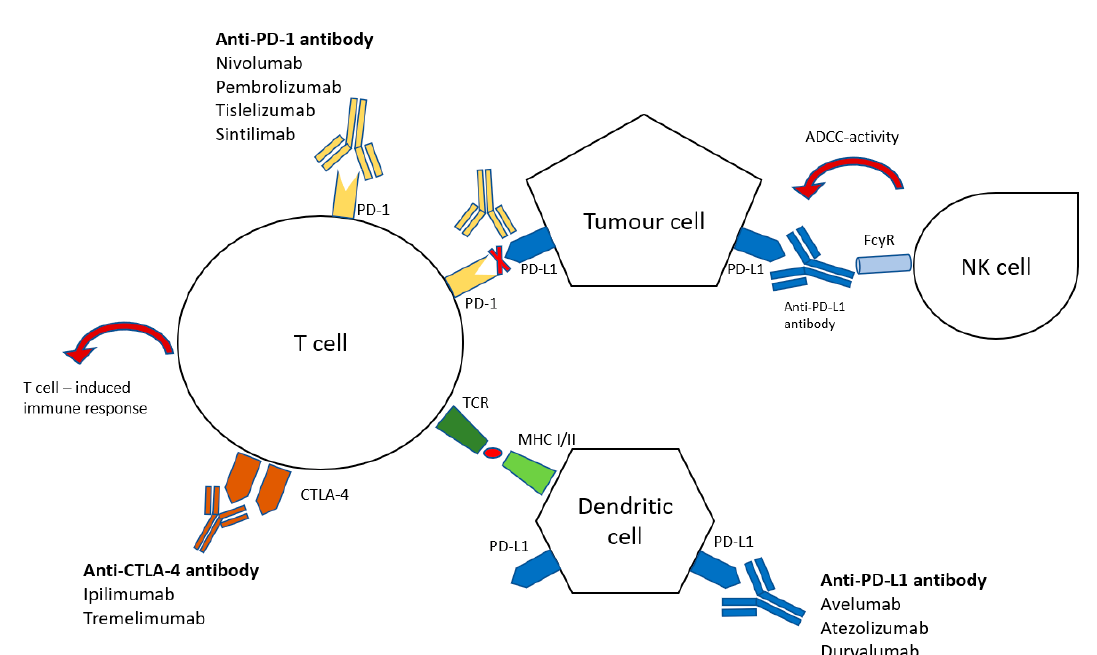
Figure 1. Functional interaction of immune system and tumour cells in checkpoint inhibition (adapted from Taieb et al., 2018 [13].) Blocking checkpoint proteins, PD-1 (programmed death receptor-1), PD-L1 (programmed death receptor ligand-1), CTLA-4 (anti-cytotoxic T-lymphocyte-associated antigen 4), amplify T-cell immune response against tumour cells by blocking inhibitory signals of tumour cells. NK—natural killer, FcyR—Fc receptors for IgG, ADCC—antibody-dependent cellular cytotoxicity, MHC I/II—major histocompatibility complex, TCR—T-cell receptor.